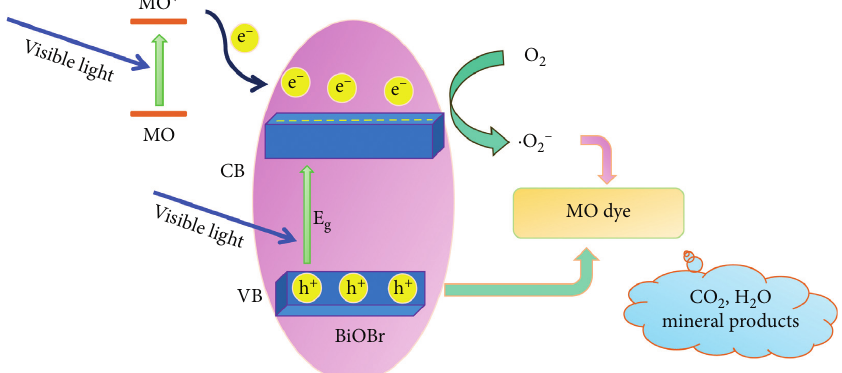
Figure 10: Photocatalytic degradation of MO with HBSMs with the addition of scavengers (IPA for OH, BQ for · O h + ) under visible irradiation for 3 h.